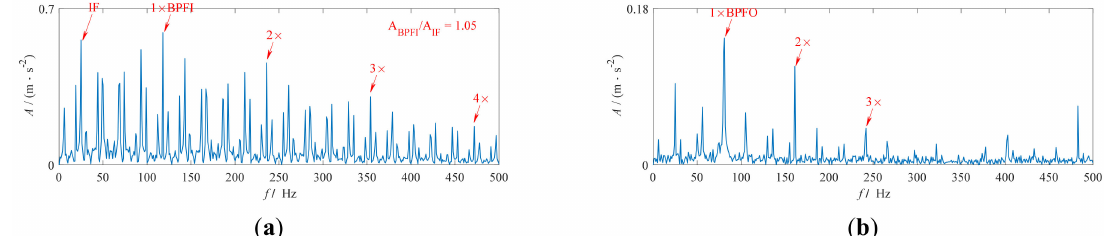
Figure 12. Results by RVMD with the traditional definition of kurtosis for the signals from MFPT: SES for ( a ) the inner and ( b ) outer race fault